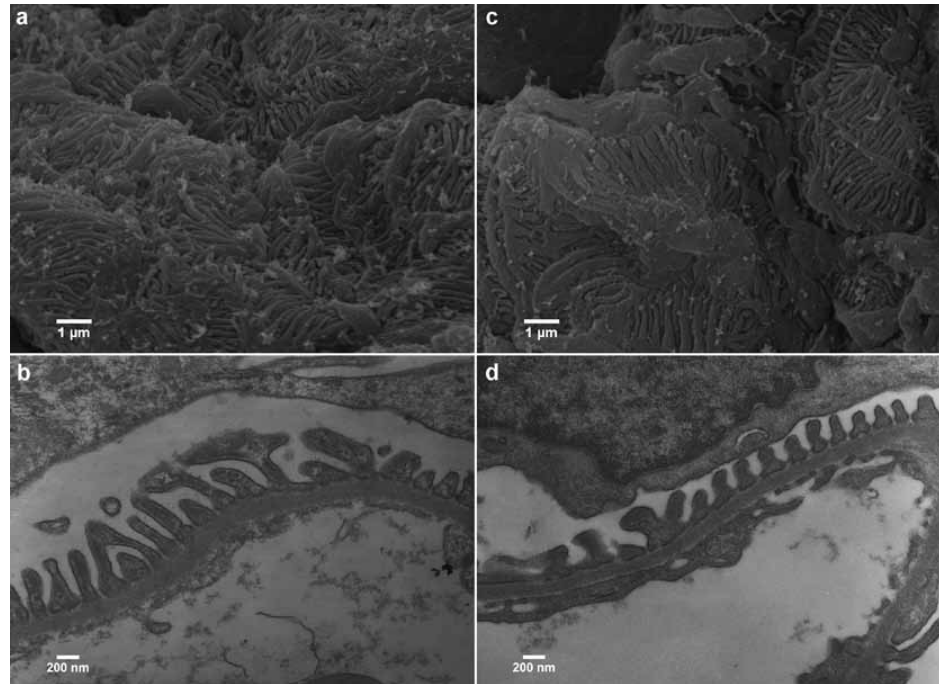
Figure 1 - Electron micrographs of glomeruli showing no difference in podocyte morphology between the sham (A and B) and pneumoperitoneum (C and D) groups. Scanning electron microscopy (A and C); Transmission electron microscopy (B and